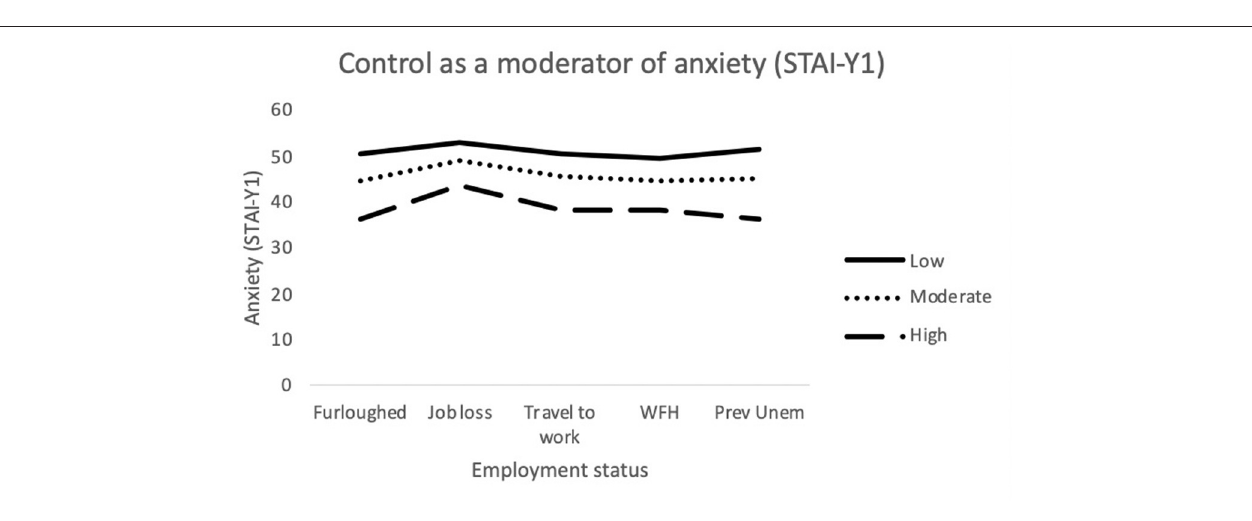
FIGURE 2 | Interaction between job outcome and Control for State Anxiety. WFH, Employed (working from home); Prev Unemp, previously